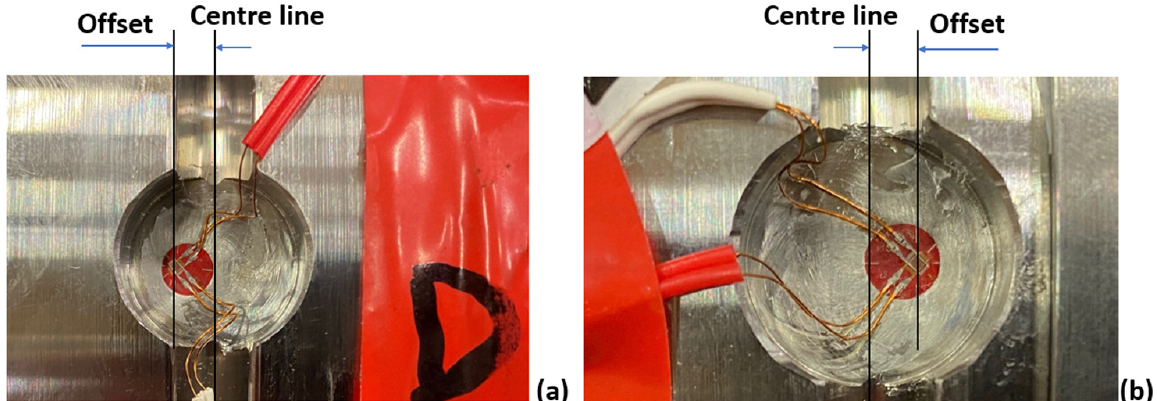
Figure 8. Examples of strain gauge offsets from pocket center line for ( a ) the cylindrical pin and ( b ) the expanding pin. Table 3. Measured and calculated strain values at real cross-sections for 0° pin rotation and 500 kN external load.